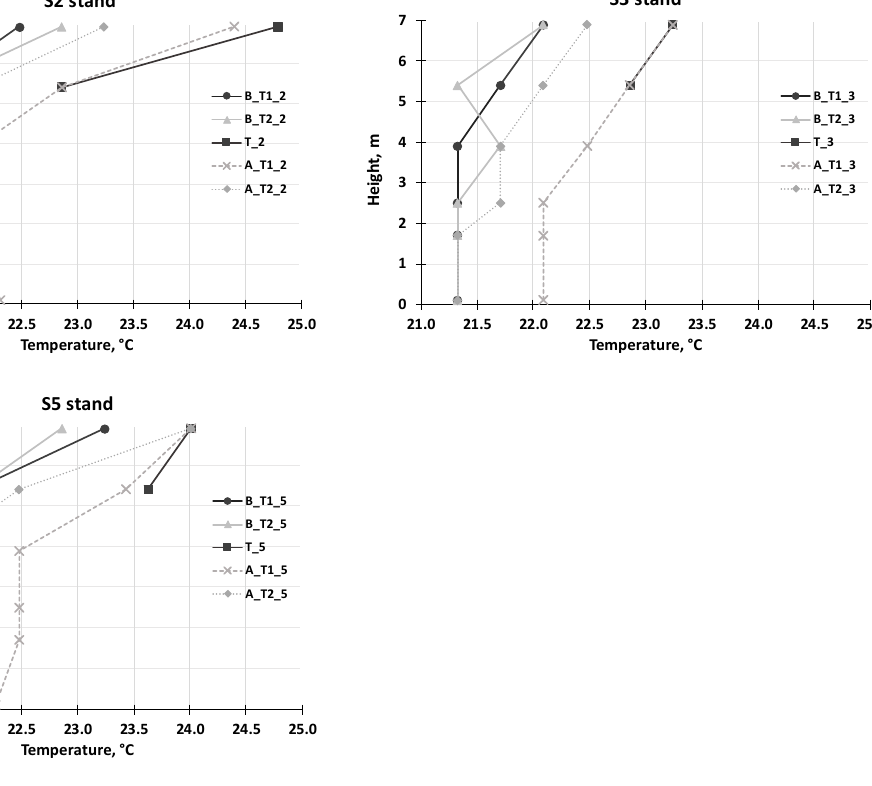
Figure 4. Indoor temperature measured at different conditions for the same location.